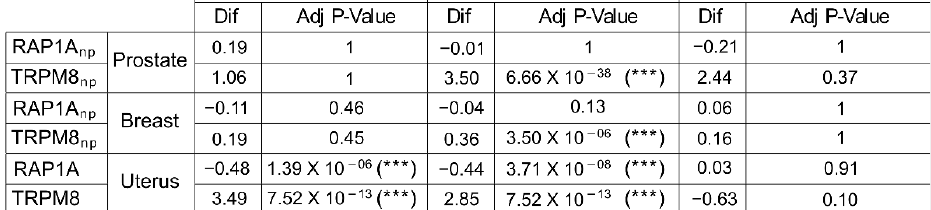
Figure 9. TRPM8 and Rap1A expression during carcinogenesis in different cancers. Differential expression analysis on Rap1A and TRPM8 transcripts in prostate ( a ), breast ( b ), and uterine ( c ) healthy and tumor (not metastatic and metastatic) patient samples from GTEx and TCGA databases, respec- tively. Results of statistical analysis are reported in the table of panel ( d ). Dif = difference between means; np = nonparametric hypothesis tests (i.e., Kruskal – Wallis H omnibus test and Dunn’s post- hoc test) . Otherwise, ANOVA and Tukey’s HSD post-hoc test were performed; statistical significance ***: p < 0.001.